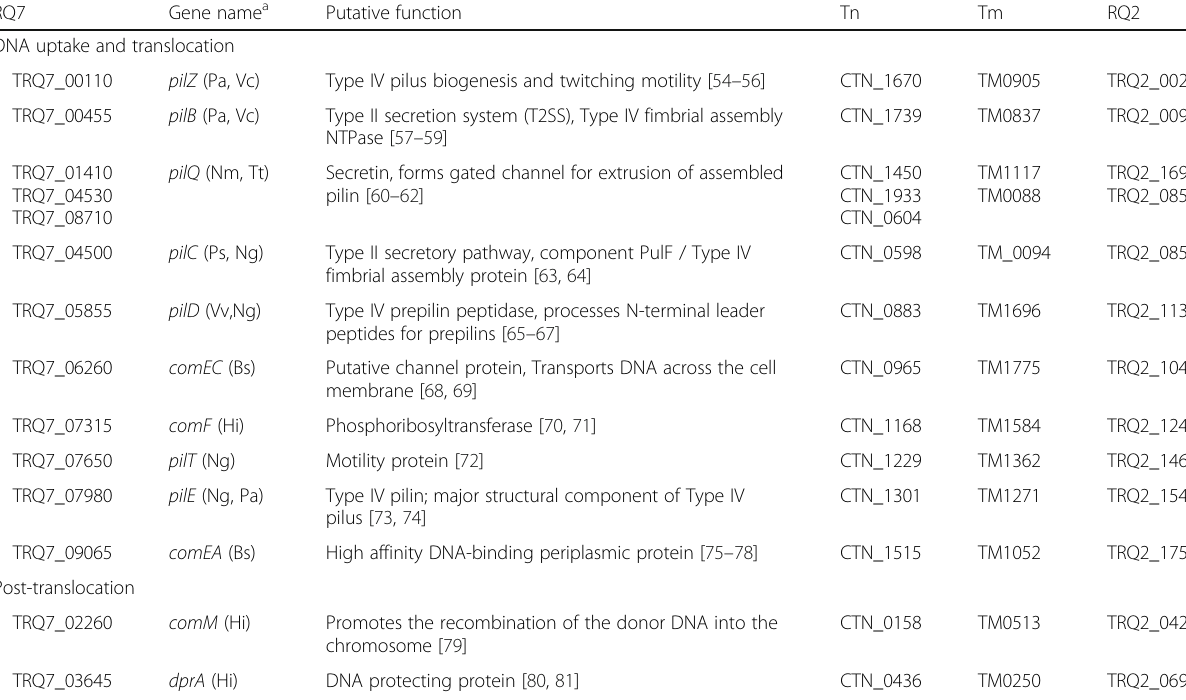
Table 6 Manually curated competence genes RQ7